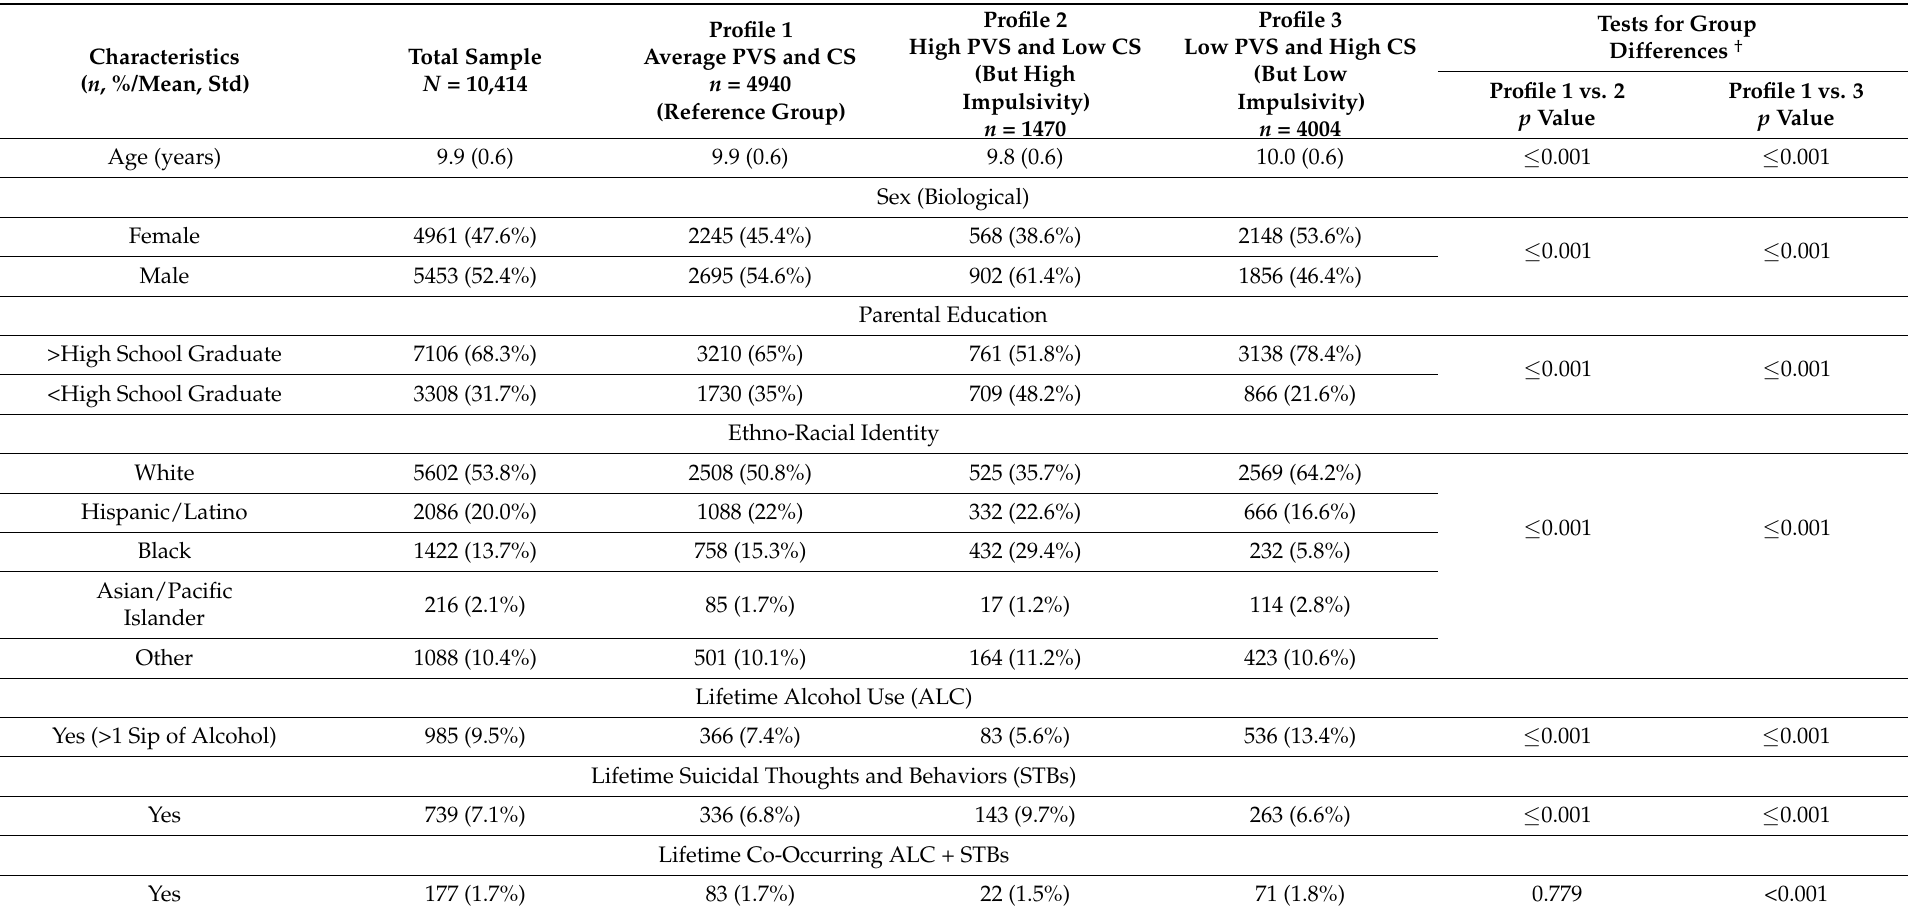
Table 1. Descriptive statistics of the positive valence systems (PVS) and neurocognitive systems (CS) profiles of suicidal thoughts and behaviors (STBs) at baseline enrollment ( n = 10,414) with children (age 9 to 10 years) in the Adolescent Brain and Cognitive Development (ABCD)